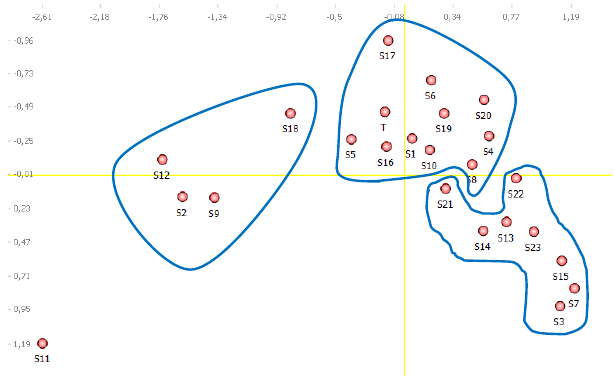
Figure 5. Role analysis graph Figure 4 represents the eigenvector centrality map of